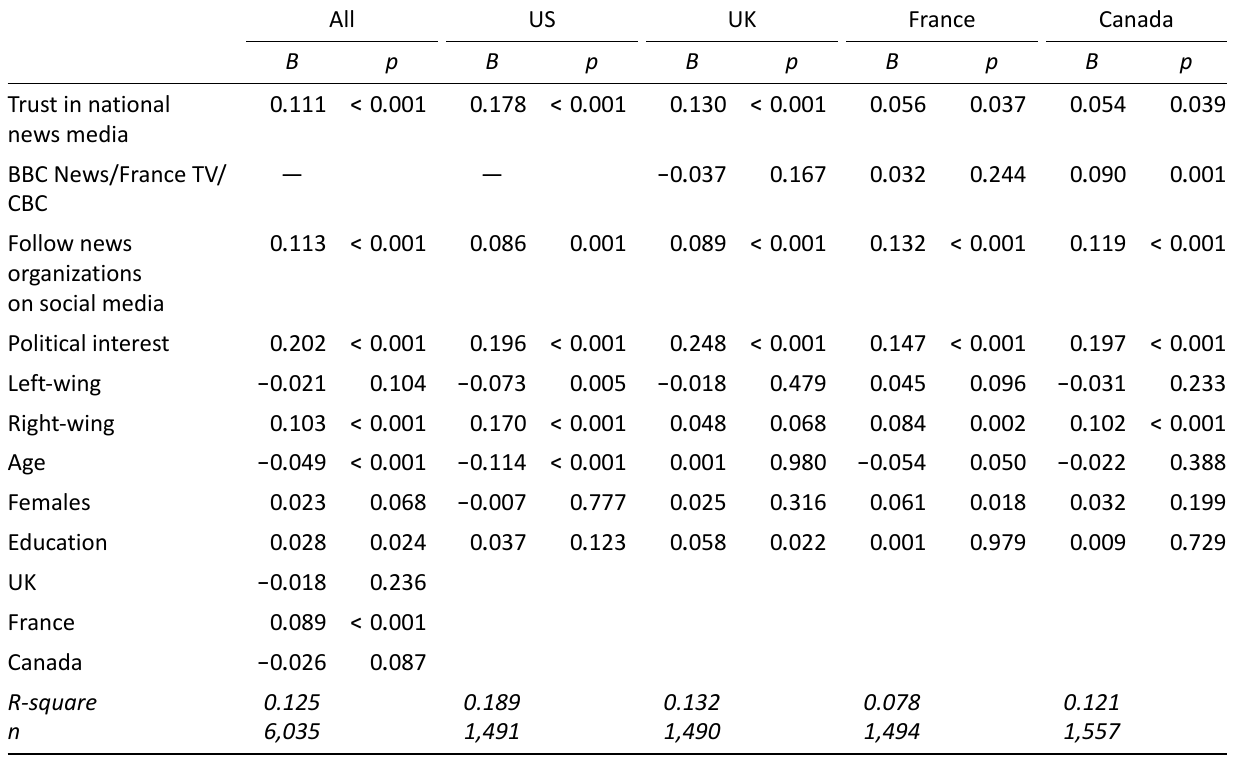
Table 3. Ordinary least squares (OLS) regression of awareness of fake news stories about Covid‐19.